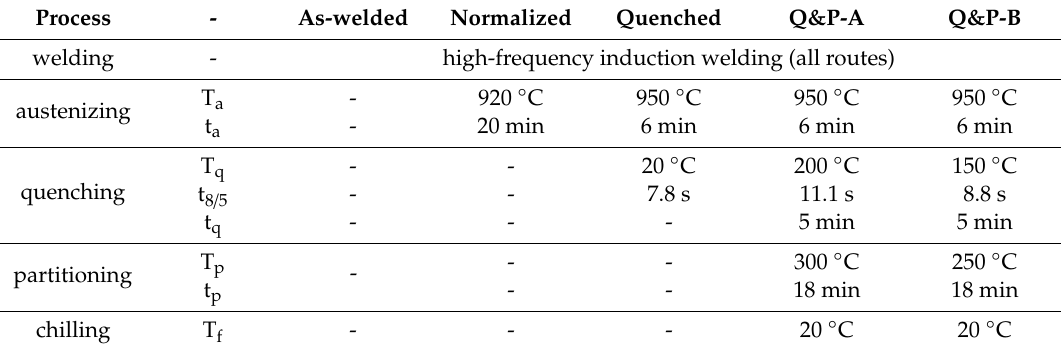
Figure 5. Thermal history sketch of the different heat treatments performed in this study. Table 2. Routes and characteristic temperatures for processing and different heat treatments. Table 2. Routes and characteristic temperatures for processing and di ff erent heat treatments.